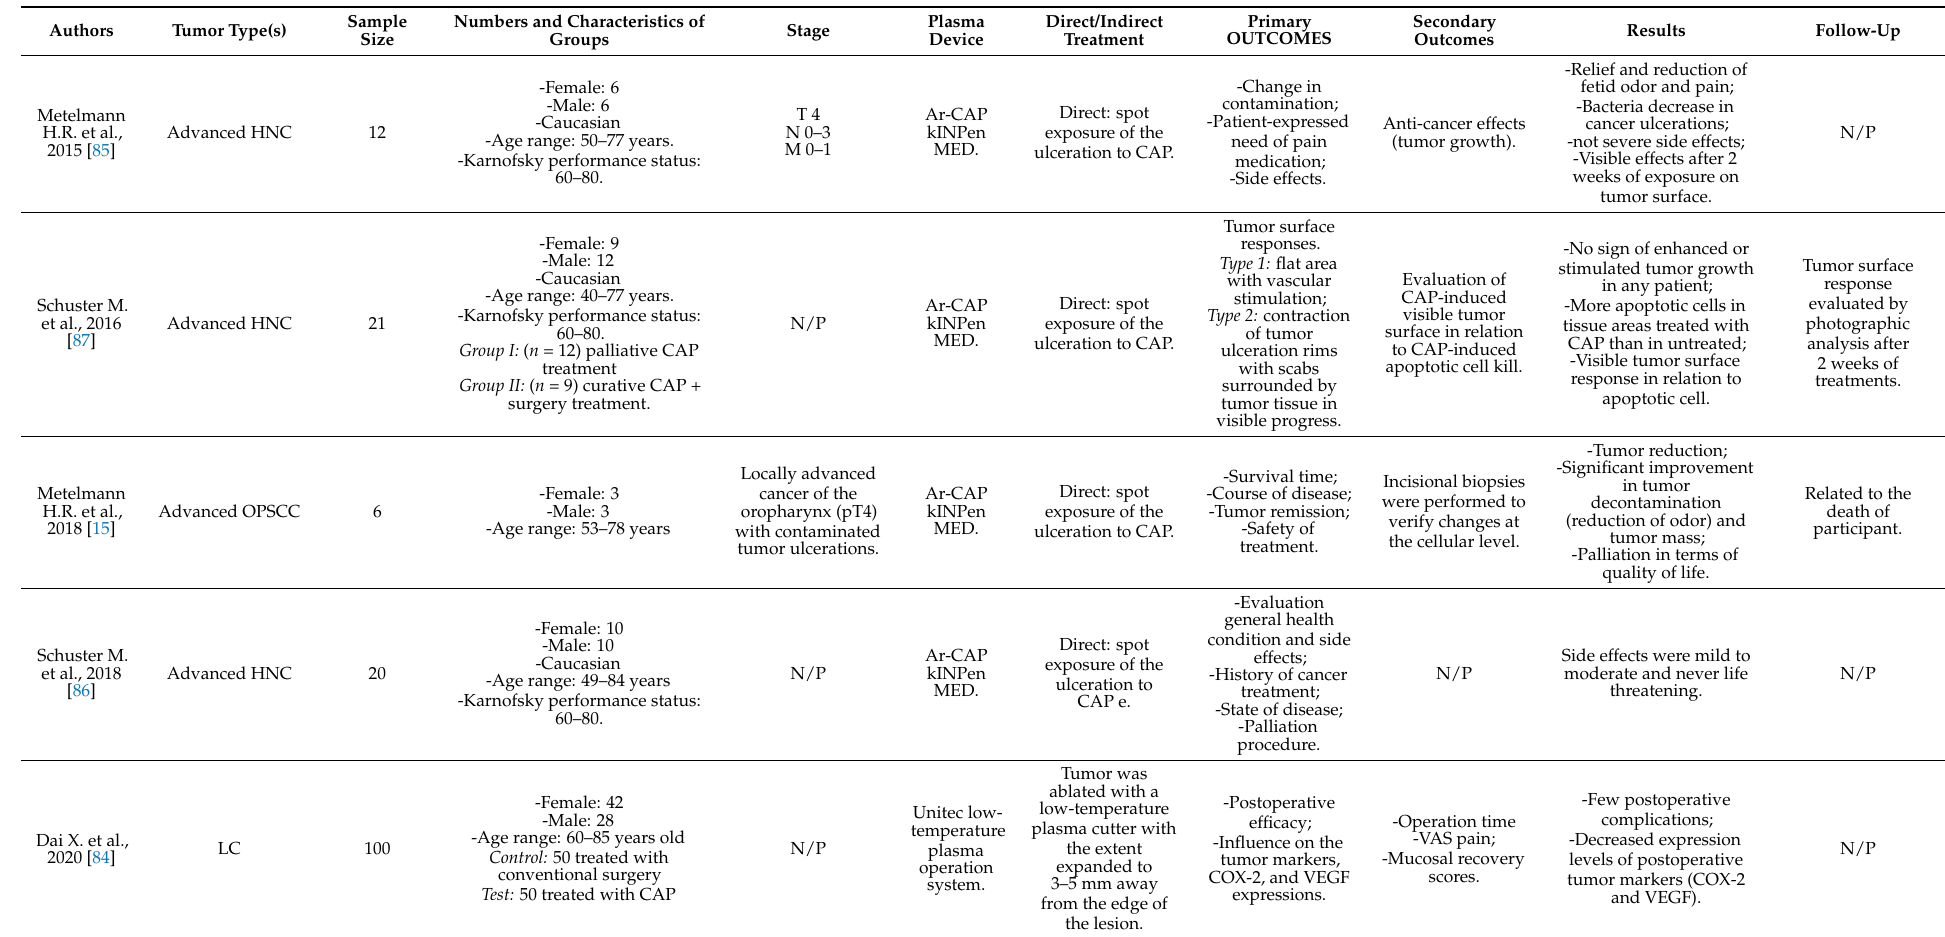
Table 3. Characteristics of clinical